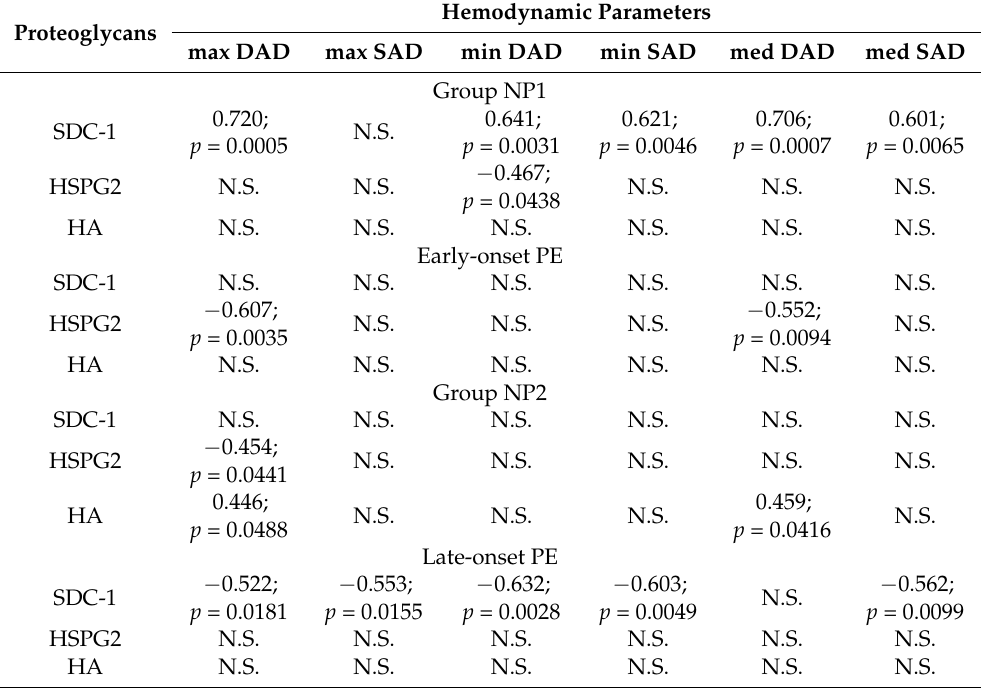
Table 5. Results of correlation analysis showing the relationship between the changes in the concen- tration of soluble components of eGC in maternal blood and maternal hemodynamic parameters in patients of all studied groups.